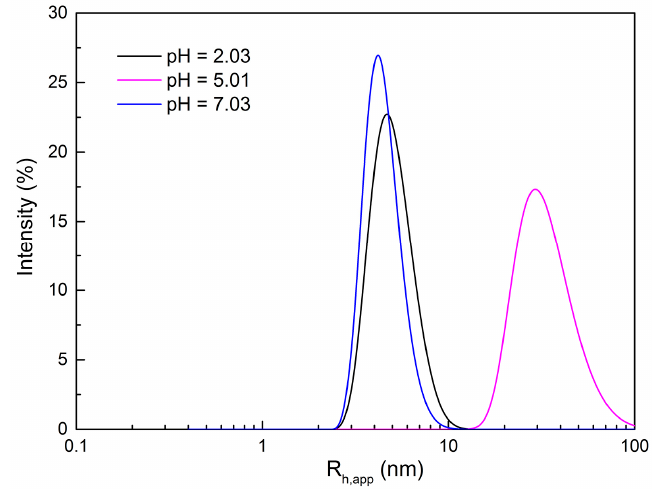
Figure 5. Size distribution of 80 mM C 16 MPBr-AA aqueous solution with different pH values.